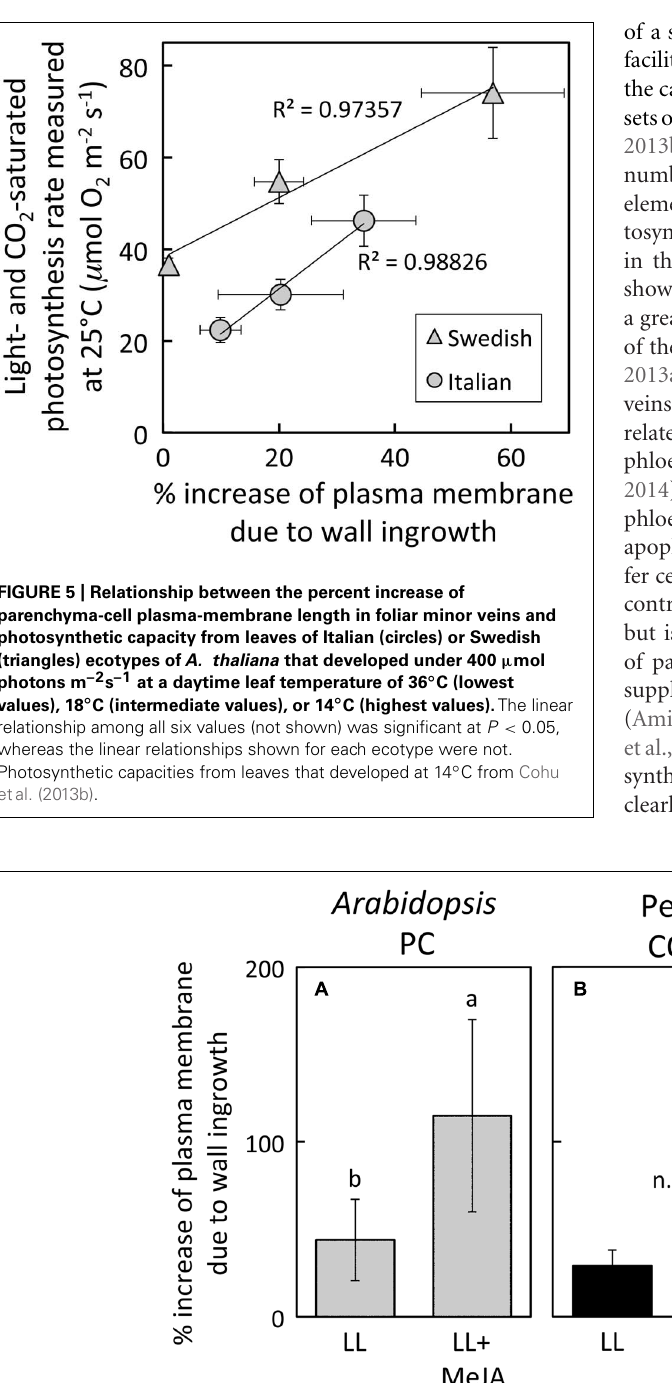
methyl jasmonate (LL + MeJA) for seven days. Gray columns indicate PCs and black columns indicate CCs. Significant differences between the means ( P < 0.05) of A. thaliana (A) and S. vulgaris (C) are denoted by different lower case letters. Percent increase of plasma membrane length was not significantly different (n.s.) between control and MeJA-treated companion cells of either pea (B) or S. vulgaris (C) . Data from Amiard etal.